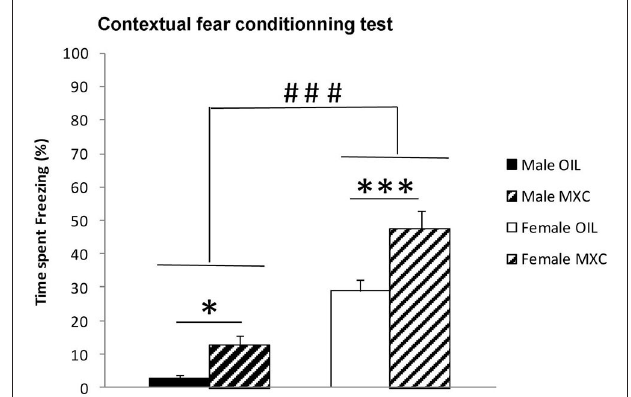
FIGURE 3 | Time spent floating, in seconds, in the FST. Male and female mice perinatally exposed to MXC exhibited no effects in the depressive-like profile evaluated in the FST. Data are expressed as mean ± SEM.